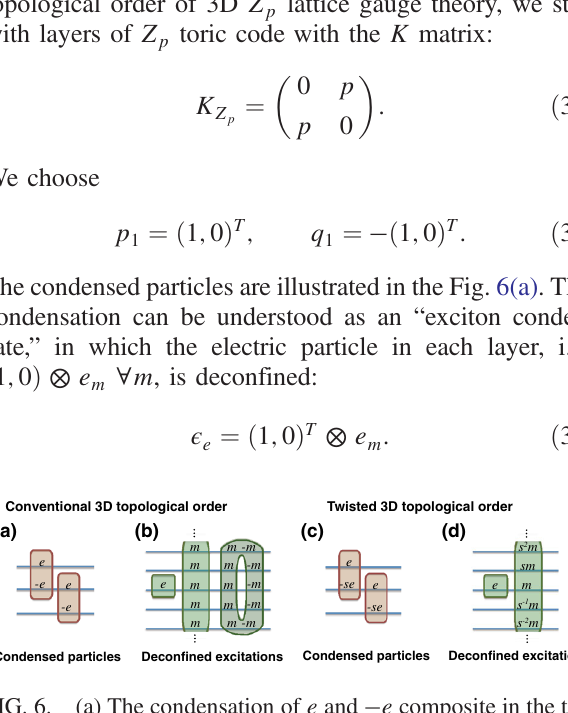
FIG. 6. (a) The condensation of e and − e composite in the two consecutive layers in the system of stacked layers of Z toric p codes. (b) The electric particle in each layer is a deconfined particle that should be identified as the electric particle in the 3D Z lattice gauge theory. The string of m particles in every layer is p a deconfined string excitation that can be viewed as the flux string in the Z gauge theory. The flux strings do not have to align p strictly along the z direction. A contractible flux string of finite size, as is shown in the figure, can be considered. (c) A different set of condensed particles in layers of Z toric code, the p condensation of which leads to the twisted lattice gauge theory (see the text). (d) The deconfined particles in the twisted theory, including an electric particle and the “ twisted ” flux